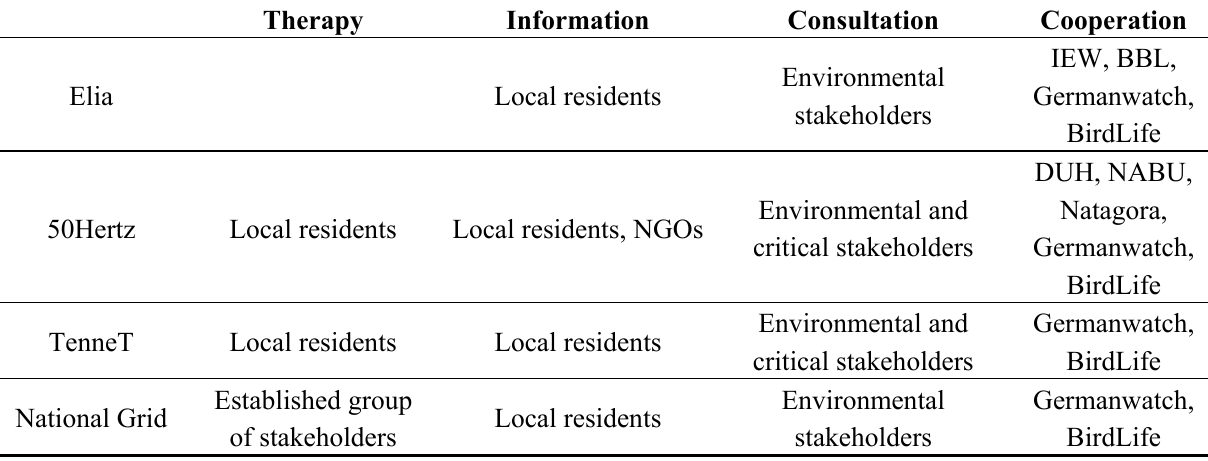
Table 2. Stakeholders in four pilot projects.